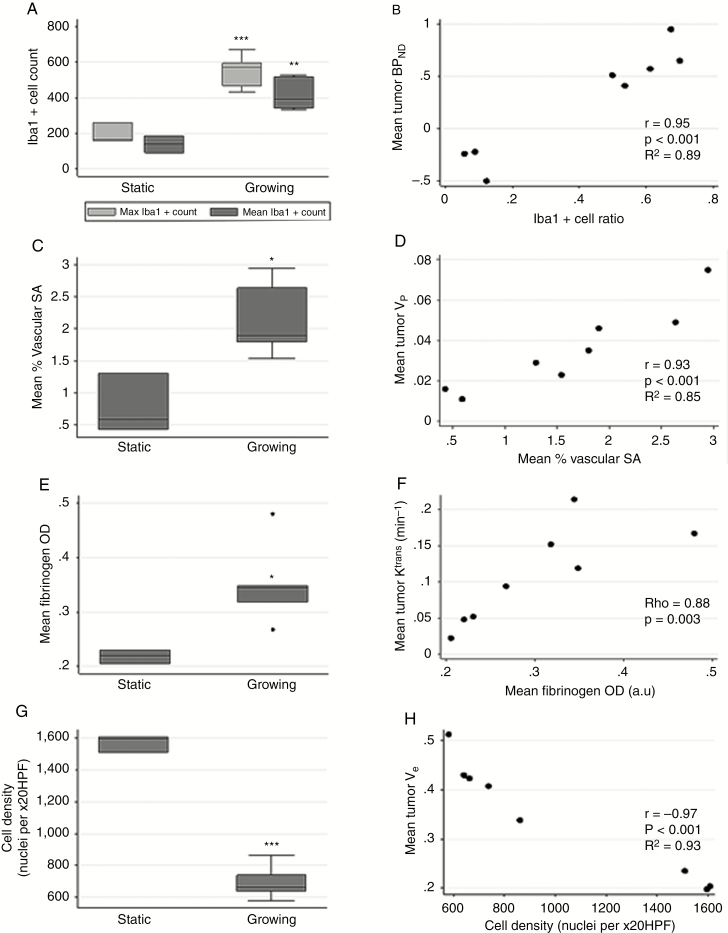
Immunohistochemistry results. Boxplot of maximum and mean tumor Iba1+ cell count per x20 high-powered field (HPF) within static and growing VS cohort (A). Intertumor scatterplot analysis of mean [11C]-(R)-PK11195 BPND against Iba1+ cell ratio (B). Boxplot of mean % vascular area (stromal area [SA]) within static and growing tumor cohort (C). Intertumor scatterplot analysis of mean tumor vp against mean % vascular area (SA) (D). Boxplot of mean optical density (OD) measurement for fibrinogen staining within static and growing tumor cohort (E). Intertumor scatterplot analysis of mean tumor Ktrans against mean fibrinogen OD (F). Boxplot of mean cell density (cell nuclei count/x20 HPF) within static and growing tumor cohort (G). Intertumor scatterplot analysis of mean cell density against mean tumor ve (extravascular-extracellular space fraction) (H). Two-tailed t-test *P ≤ 0.05, **P ≤ 0.01, ***P ≤ 0.001.